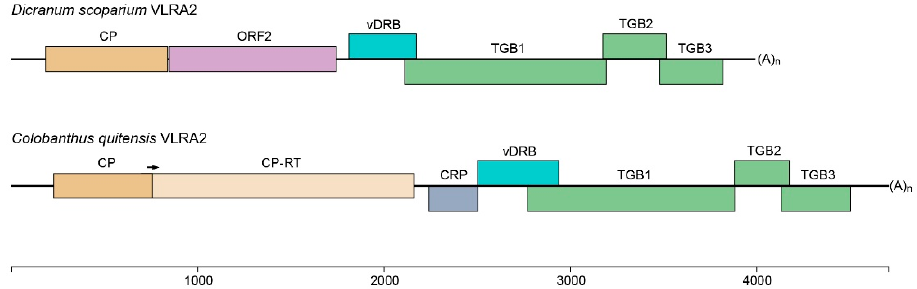
Figure 2. Comparison of gene organization of predicted RNA2 genomic components encoding putative multicomponent cell-to-cell transport systems in D. scoparium and C. quitensis VLRAs. Genes are shown as boxes with the names of the encoded proteins. Genes of proteins potentially involved in cell-to-cell movement are shown in green (TGB counterparts), light green (vDRB) and blue-green (CRP). Genes encoding small hydrophobic proteins are shown in blue. Replicative genes are shown in yellow. Arrows indicate read-through codons in CP-RT proteins. CRP—cysteine-rich protein, vDRB—virus double-stranded RNA-binding protein, CP-RT—coat protein read-through protein.